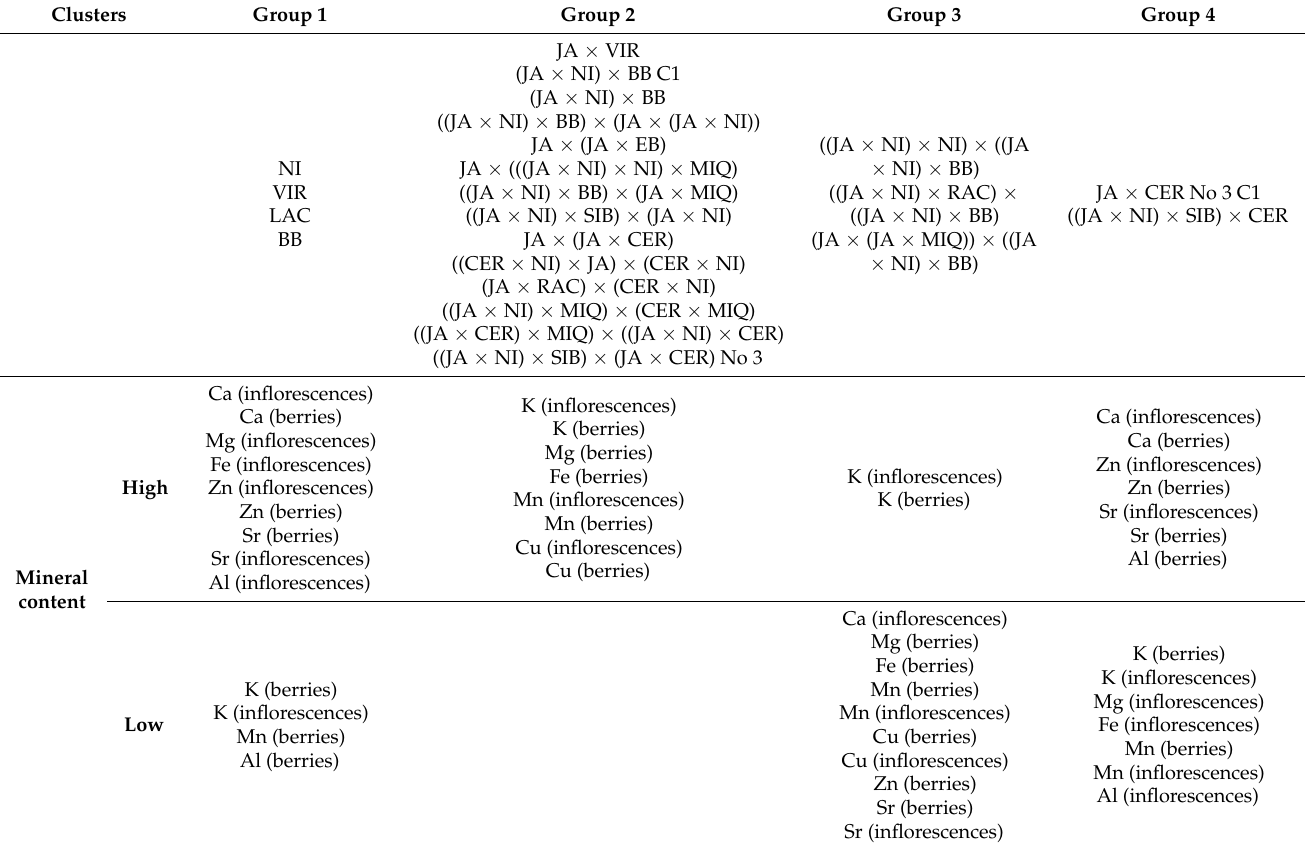
Table 1. Cluster analysis results with properties of inflorescences and berries of each cluster obtained from principal component analysis (PCA) analysis.